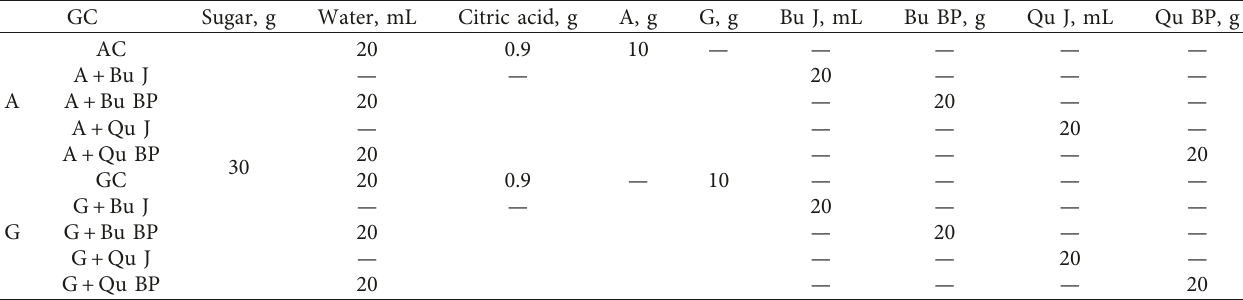
Table 1: Chewing candy